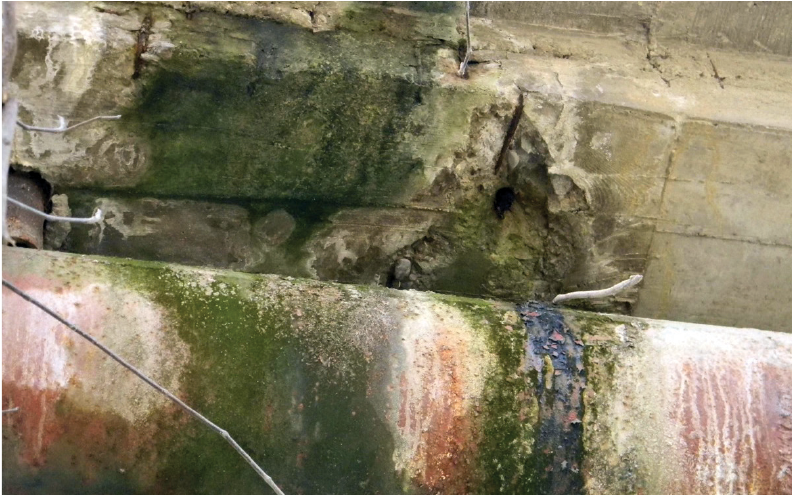
Figure 9. A typical water